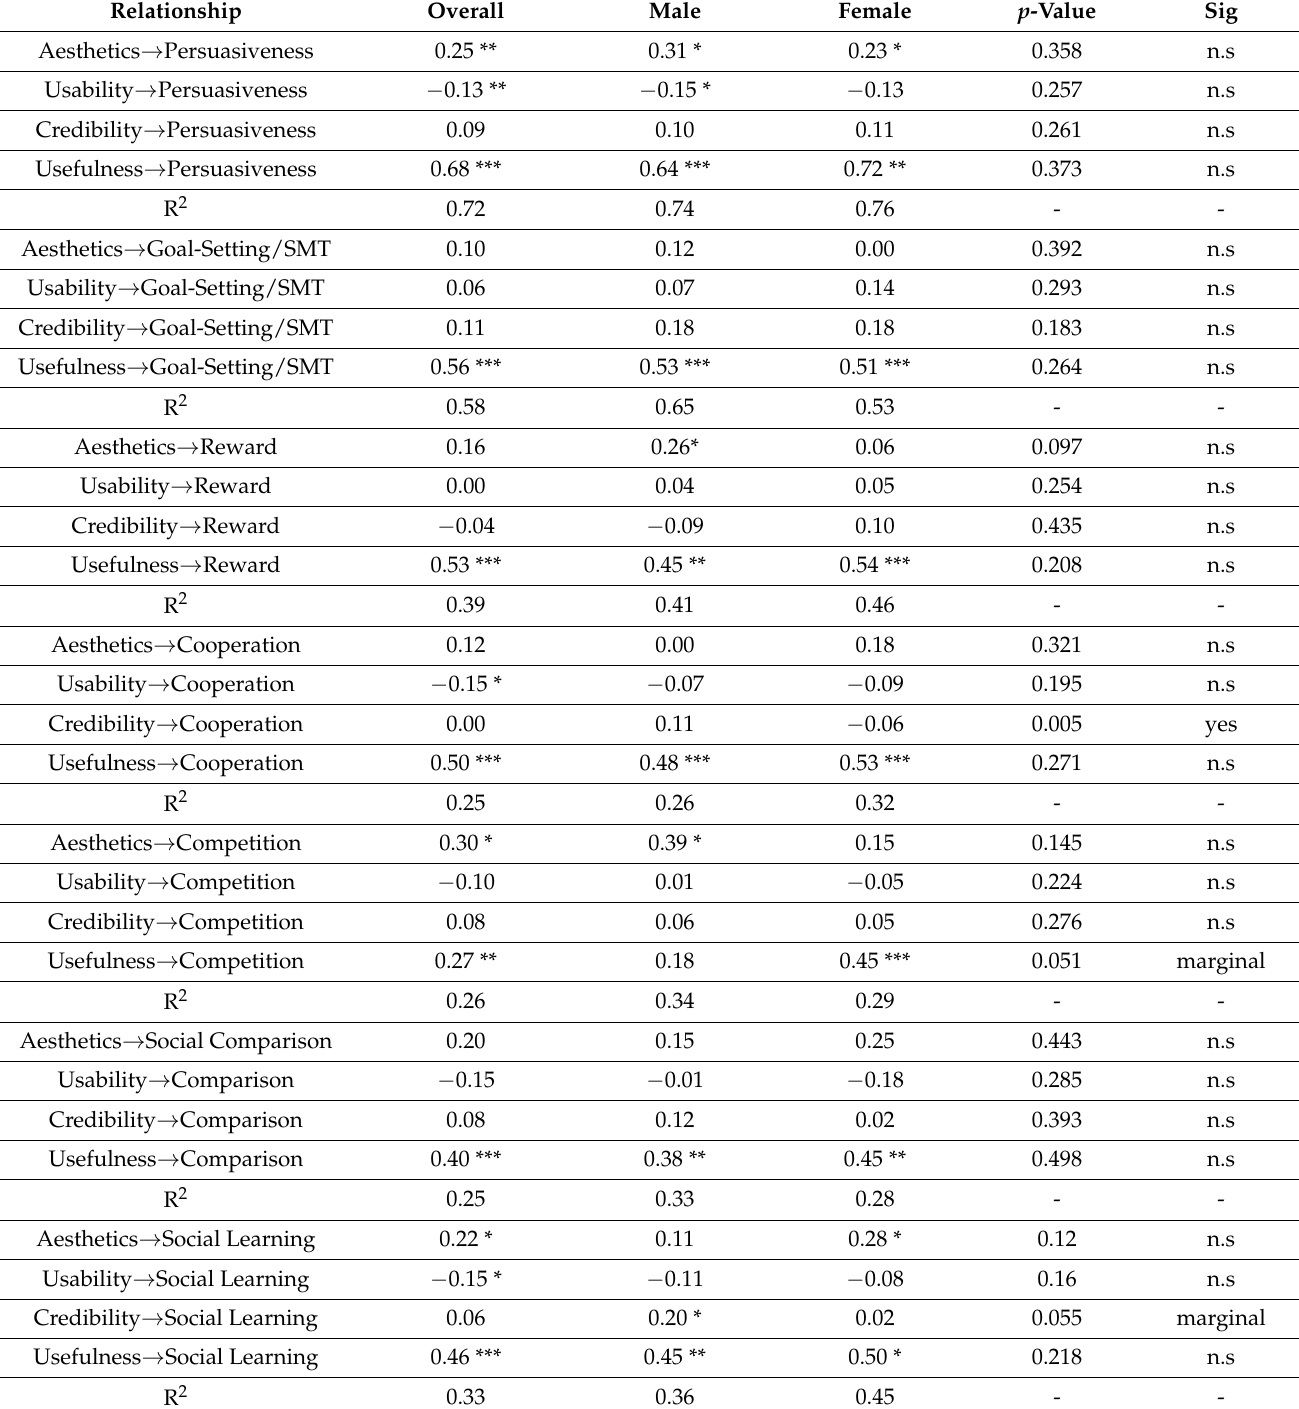
Table 6. Gender-based multigroup analysis. SMT = Self-Monitoring, sig = significance, n.s = non-significant, * p < 0.05, ** p < 0.01, *** p <